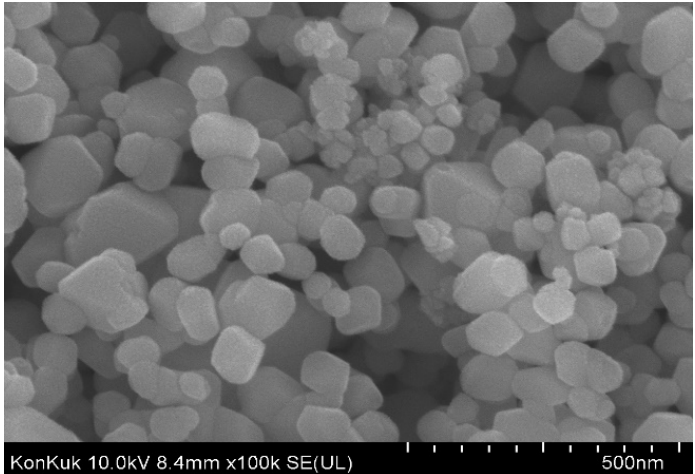
Figure 4. SEM image of Psidium guajava Co 3 O 4